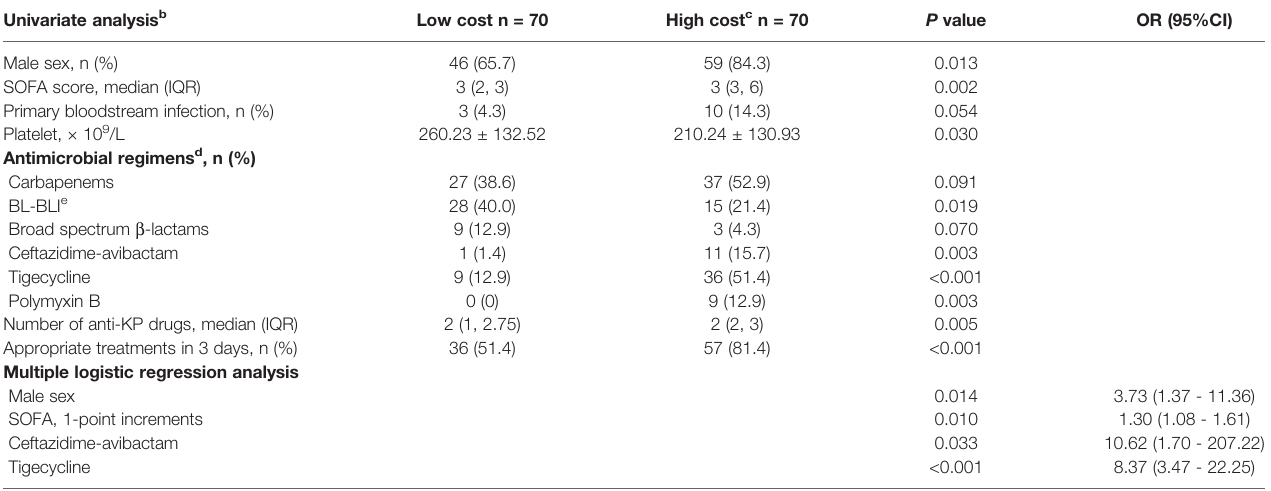
TABLE 3 | Factors associated with high cost of antimicrobial agents a